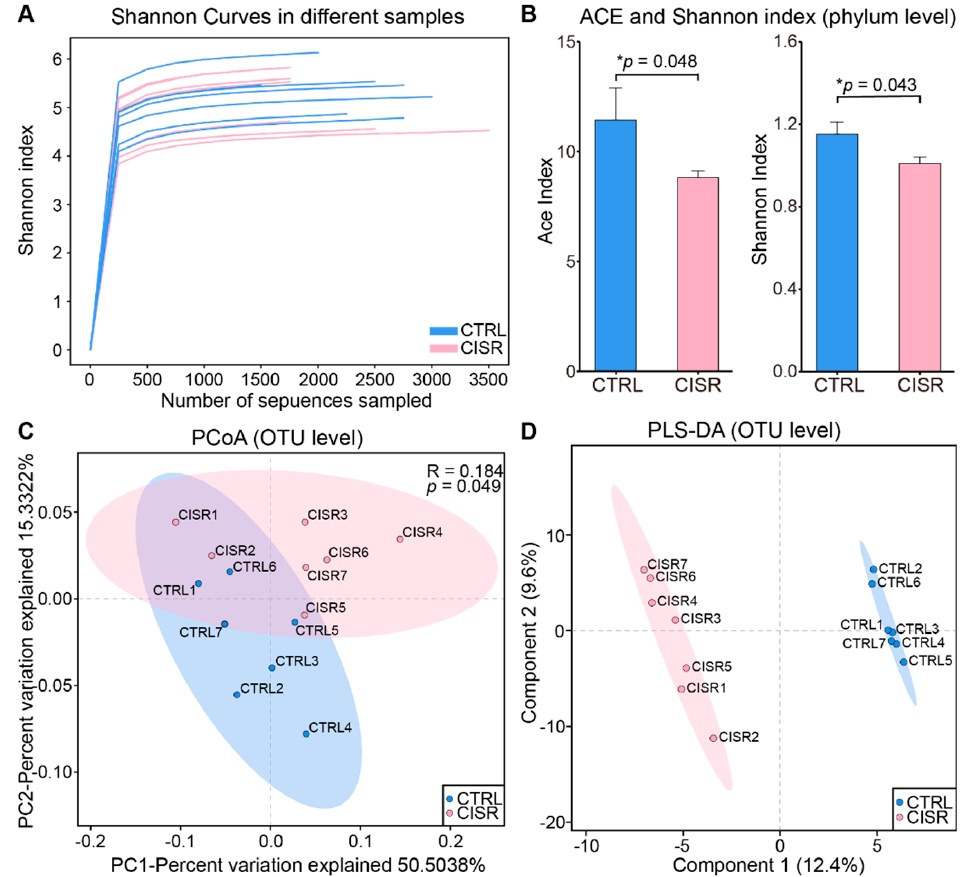
Figure 2. α and β diversity analysis of gut microbiota showed differences between the CTRL and CISR groups. ( A ) The Shannon index curves of all samples. ( B ) Comparison of ACE (abundance- based coverage estimators) and Shannon index between CTRL and CISR groups at the phylum level. The values were presented as the mean ± SEM. Significant differences were indicated by asterisks (Wilcoxon rank-sum test, * p < 0.05). ( C ) A principal coordinate analysis (PCoA) based on a weighted UniFrac analysis of the CTRL and CISR samples. ( D ) A partial least squares discriminant analysis (PLS-DA) indicated that CTRL and CISR samples clustered in separate groups.